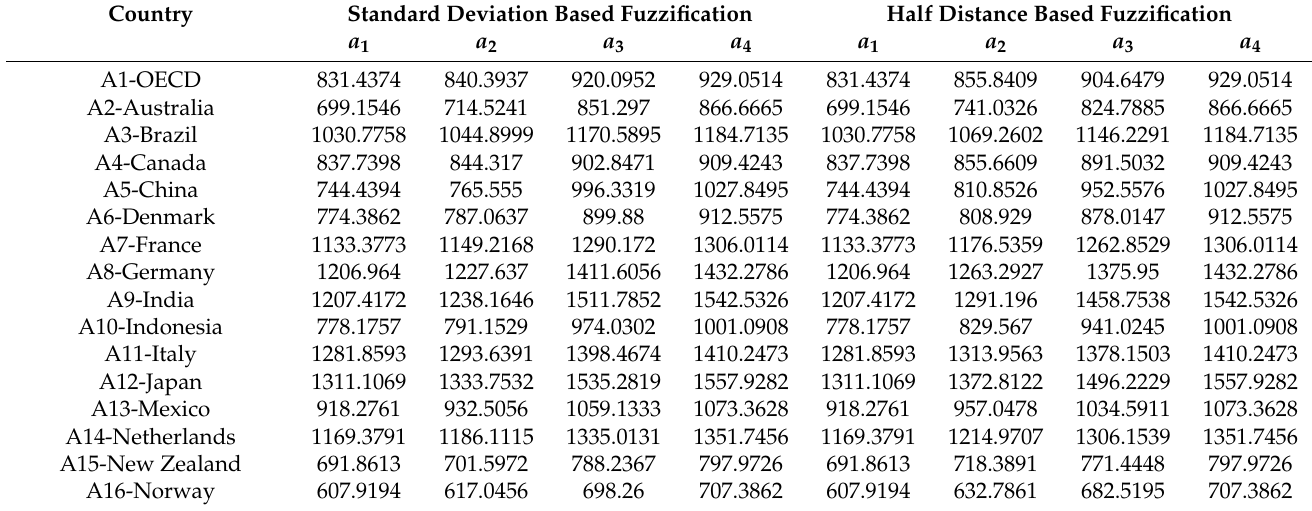
Table A2. IESRI fuzzy values forecasted for the 2020–2030 period, obtained using the forecasted values of the category.